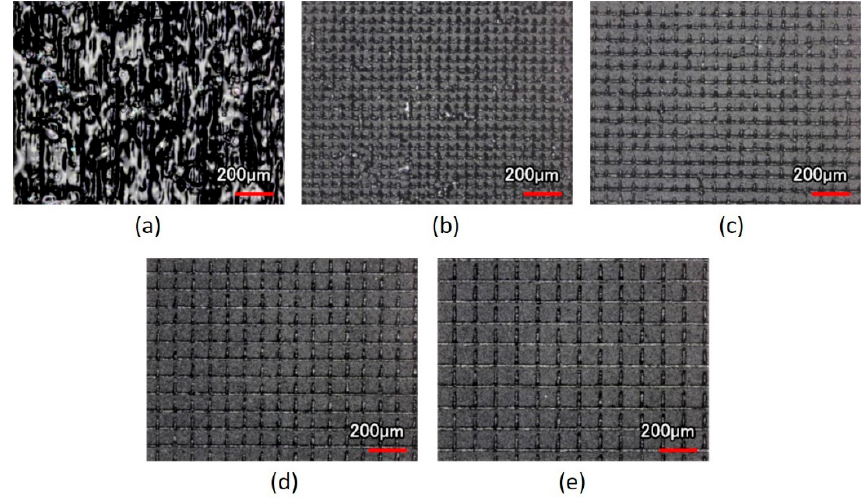
Figure 4. Optical images of the XO RGP contact lens treated with the laser system with a scanning speed of 500 mm / s and line pitches of ( a ) 30, ( b ) 50, ( c ) 70, ( d ) 90, and ( e ) 110 µ m.